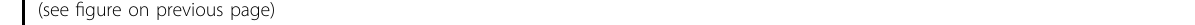
Fig. 1 Discovery of a novel potent STING agonist HB3089. a Chemical structure of HB3089. b, c The thermal stability of human STING (R232) and mouse STING (R231) bound with HB3089 or diABZI (compound 3) in DSF assay. The data were shown as the mean values of d(RFU)/dt, n = 3. d HB3089 dose-dependently activated the ISG reporter in THP1-Dual cells after 24 h treatment. e The activation of ISG reporter by HB3089 (1 μ M) was abolished in THP1-Dual-KO-STING cells after 24 h treatment. f HB3089 activated ISG reporter in RAW-Lucia cells after 24 h treatment. g The activation of ISG reporter by HB3089 (50 μ M) was abolished in RAW-Lucia KO-STING cells after 24 h treatment. h Anti-tumor effect of HB3089 and diABZI (compound 3) in 4T1 breast tumor of Balb/c mice by intravenous (IV) administration on days 1, 4, 7, n = 6. i Anti-tumor effect of HB3089 in EMT6 breast tumor of Balb/c mice by IV administration, n = 6. Arrows indicate the days (1, 4, 7) of administration. ** P < 0.01, **** P < 0.0001, Two-way ANOVA. j EMT6 tumor growth in naïve mice and rechallenged mice, the number of EMT6 tumor-bearing mice and total mice were shown, respectively. k – n Frequency of CD86 + DC, CD86 + macrophages, GMZB + CD8T cells and IFN γ + CD8T cells in blood (24 h) and tumor tissues (24 h and 72 h) of 4T1 tumor-bearing Balb/c mice, n = 8. HB3089 was administrated by IV at 2 mg/kg. ns, not signi fi cant; * P < 0.05, *** P < 0.001 , two-tailed Student ’ s t- (Supplementary Fig. S4a, b). Concordantly, peripheral and tumor in fi ltrated CD8 + T cells (Supplementary Fig. S4c), as well as GMZB + CD8T and IFN γ + CD8T were increased by HB3089 treatment (Fig. 1m, n), suggesting the activa- tion of antitumor immunity.